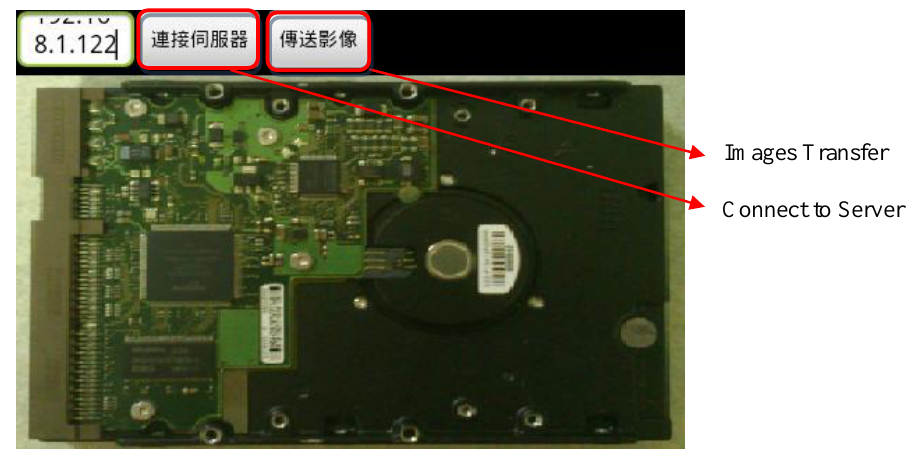
Figure 8. Image acquisition and camera control